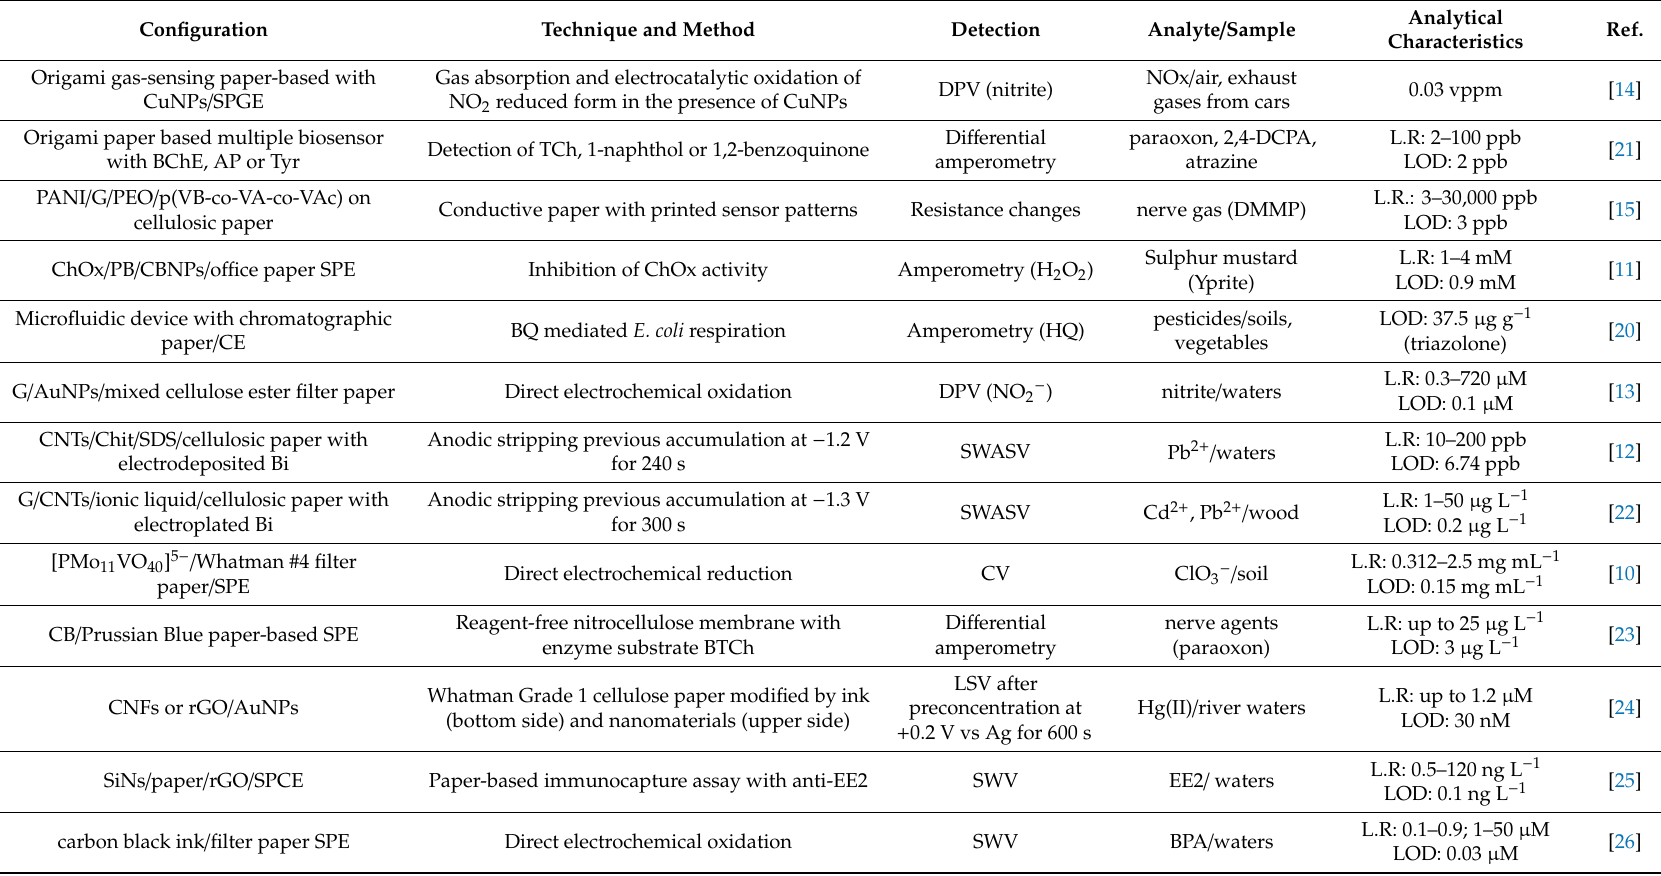
Table 1. Screen-printed paper electrochemical (bio)sensors for environmental